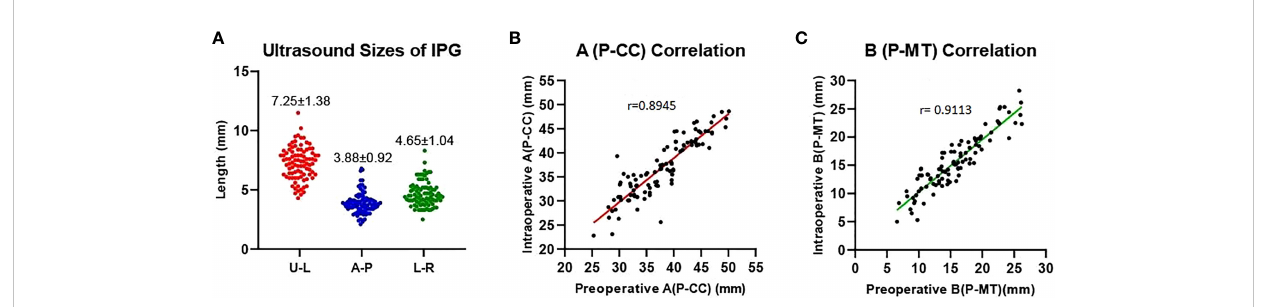
FIGURE 5 Preoperative ultrasound measurements of the IPG. (A) Ultrasound sizes of IPG (U-L: upper-lower diameters, A-P: anterior-posterior diameters, L-R: left-right diameters); (B, C) Preoperative and intraoperative distance correlation. Distance of the IPG from the cricoid cartilage (A, P-CC), distance of the IPG from the midline of the trachea (B,